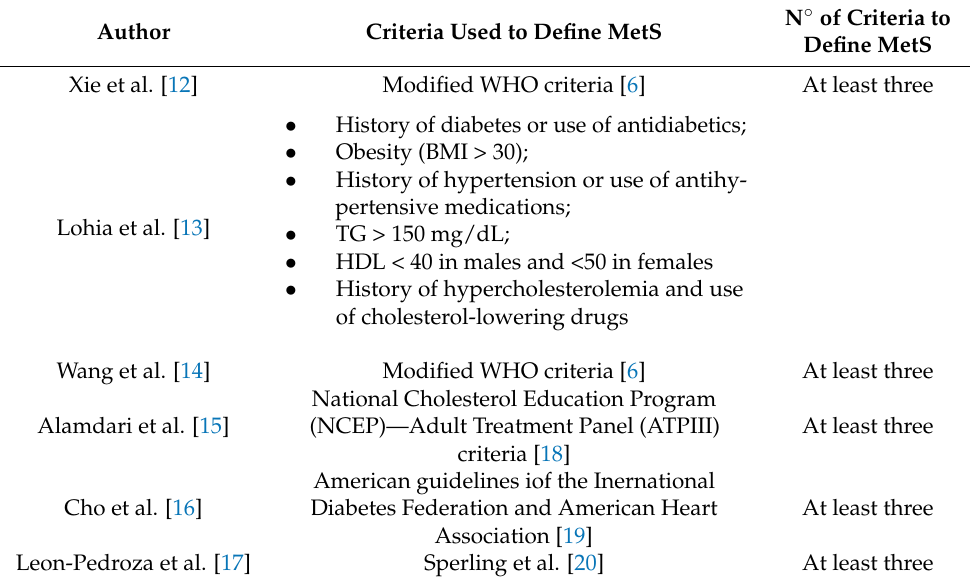
Table 3. Criteria used by the revised studies to define the metabolic syndrome. BMI. Body